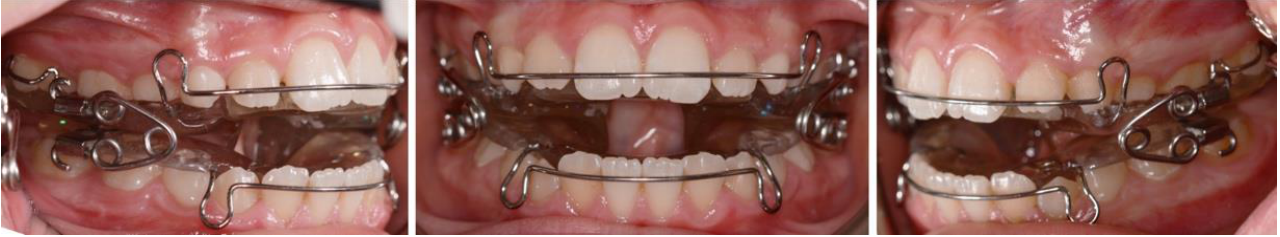
Figure 1. PK appliance.